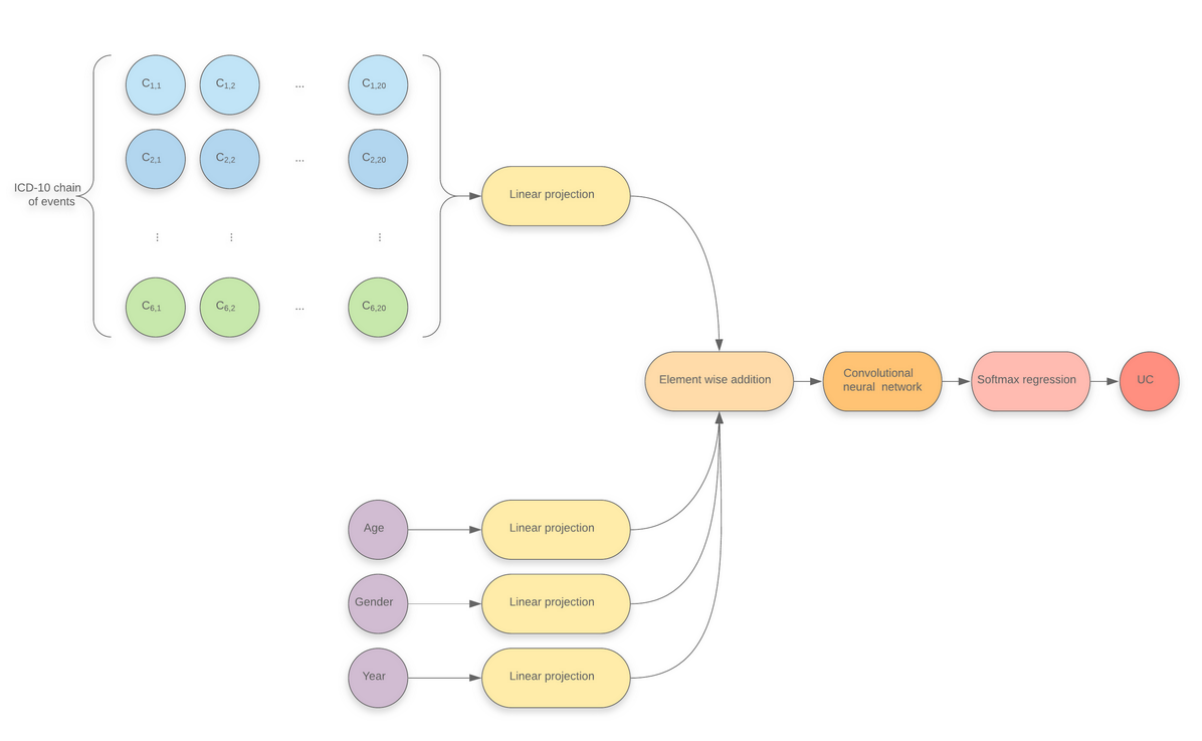
Figure 3. Overall model architecture. Ci,j: denotes the jth code at the ith line in the death certificate; ICD-10: 10th revision of the International Statistical Classification of Diseases and Related Health Problems; UC: underlying